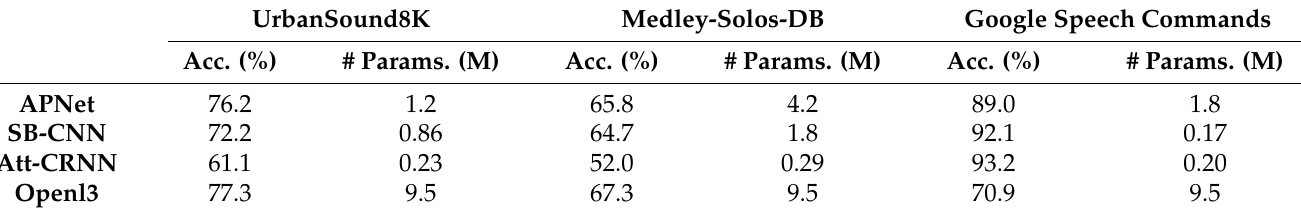
Table 3. Mean accuracy (%) and number of parameters (millions) for each model and dataset.